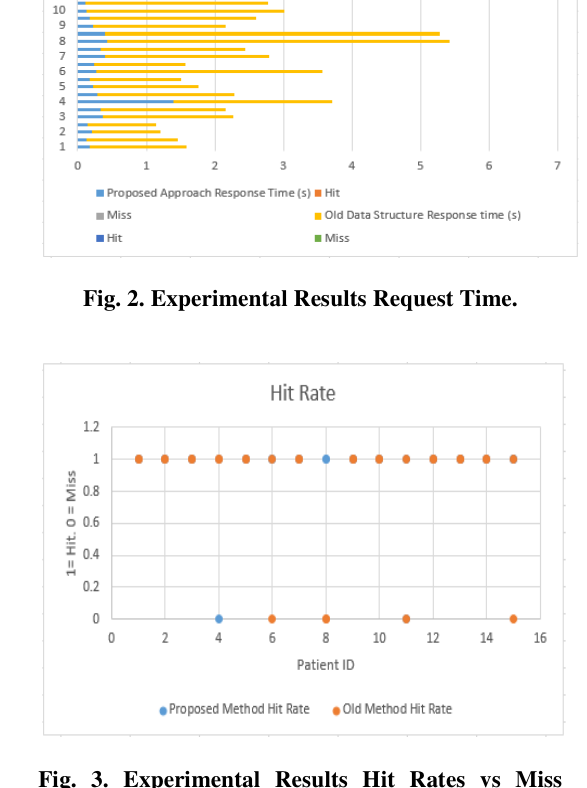
Fig. 3. Experimental Results Hit Rates vs Miss